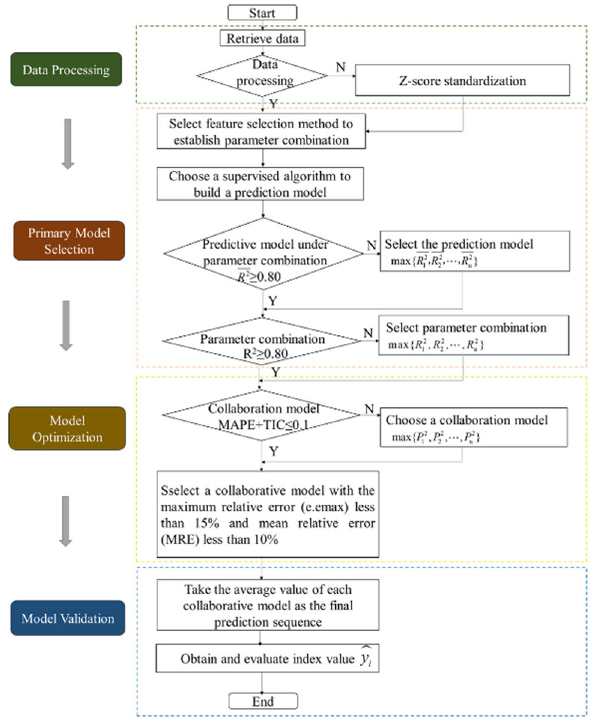
Fig. 2 Establish flow chart of prediction